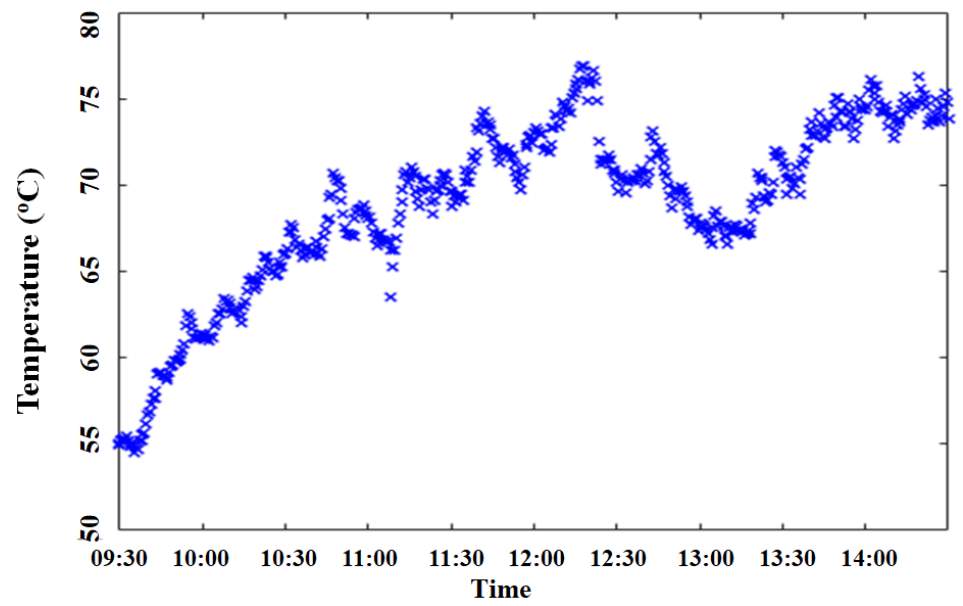
Figure 8. The surface temperature of the solar panel.